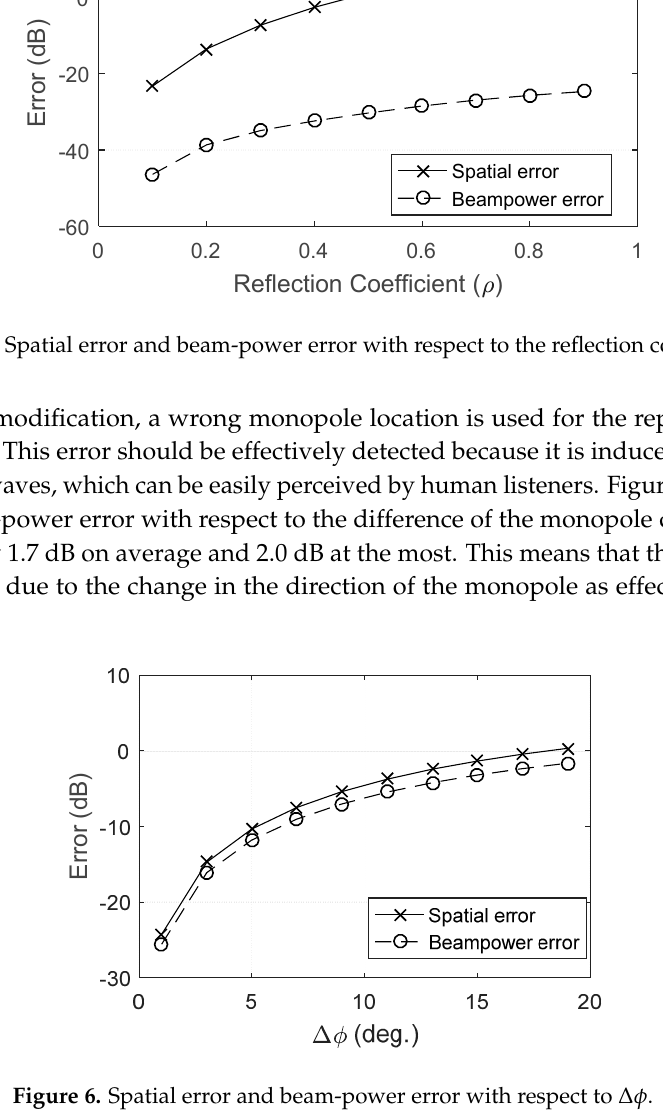
ρ = 0.9. ρ = 0.9. ρ = 0.9.